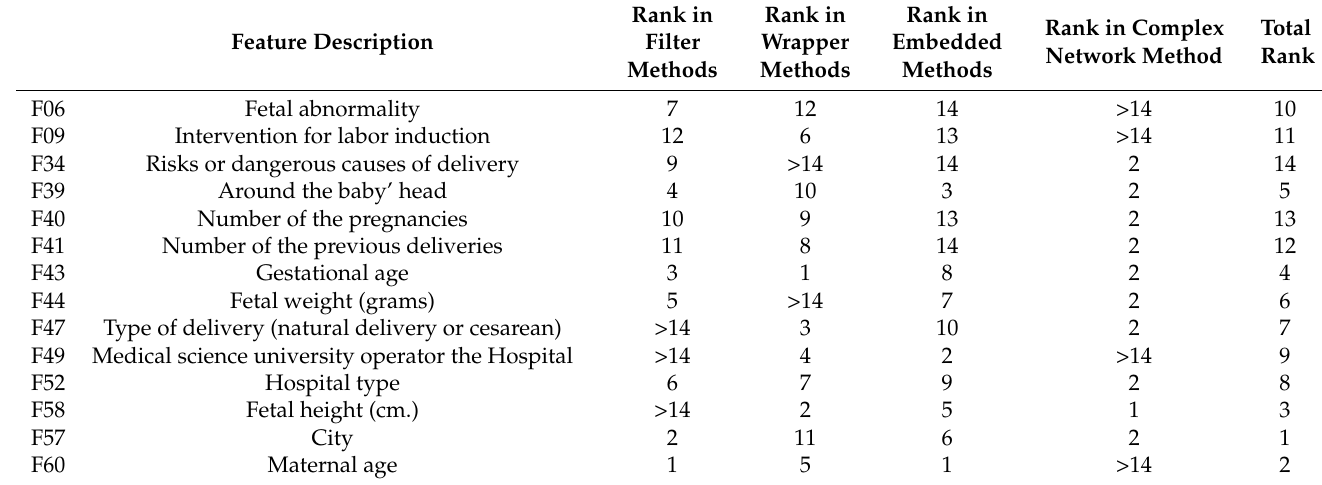
Table 4. Top features selected by different feature scoring methods in this study.